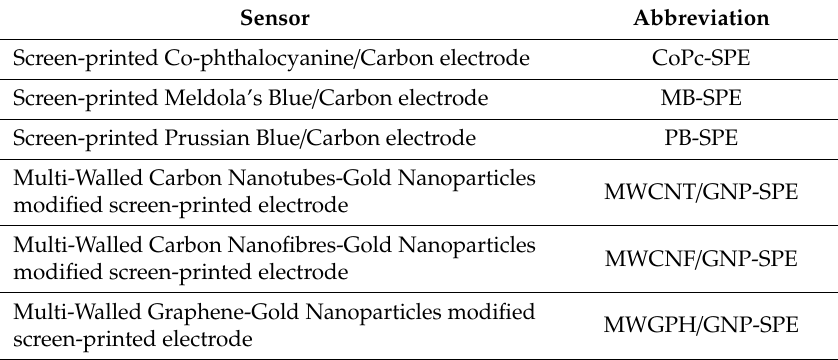
Table 2. Voltammetric sensors